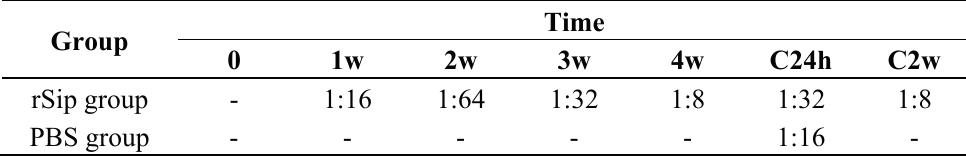
Table 4. IgM antibody titers detected by